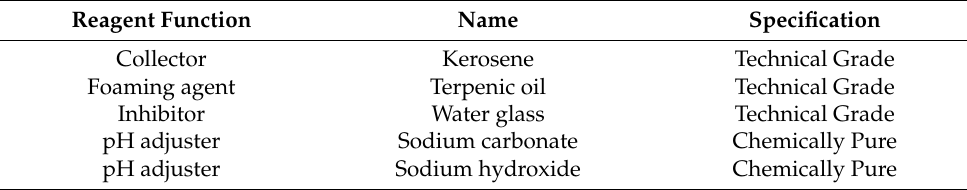
Table 4. Experimental reagent details.